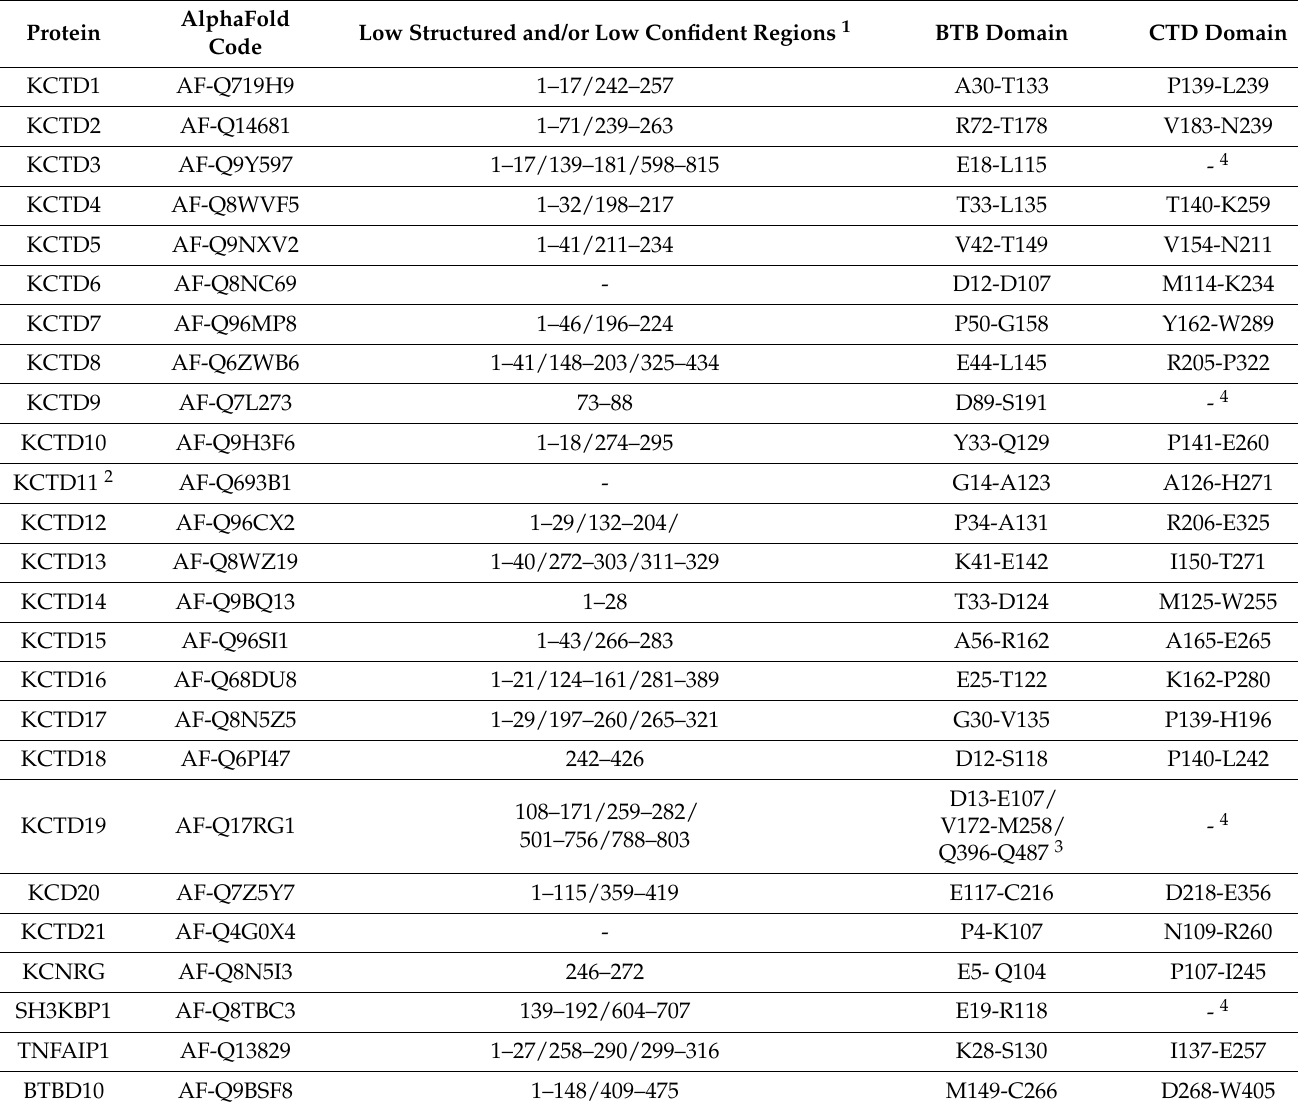
Table 2. Details of the KCTD AlphaFold